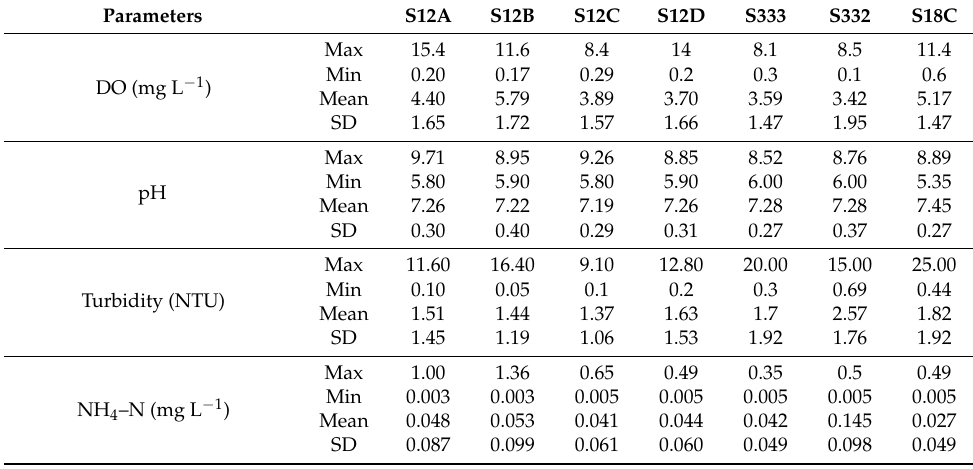
Table 2. Basic statistics of the monthly measured data at seven stations